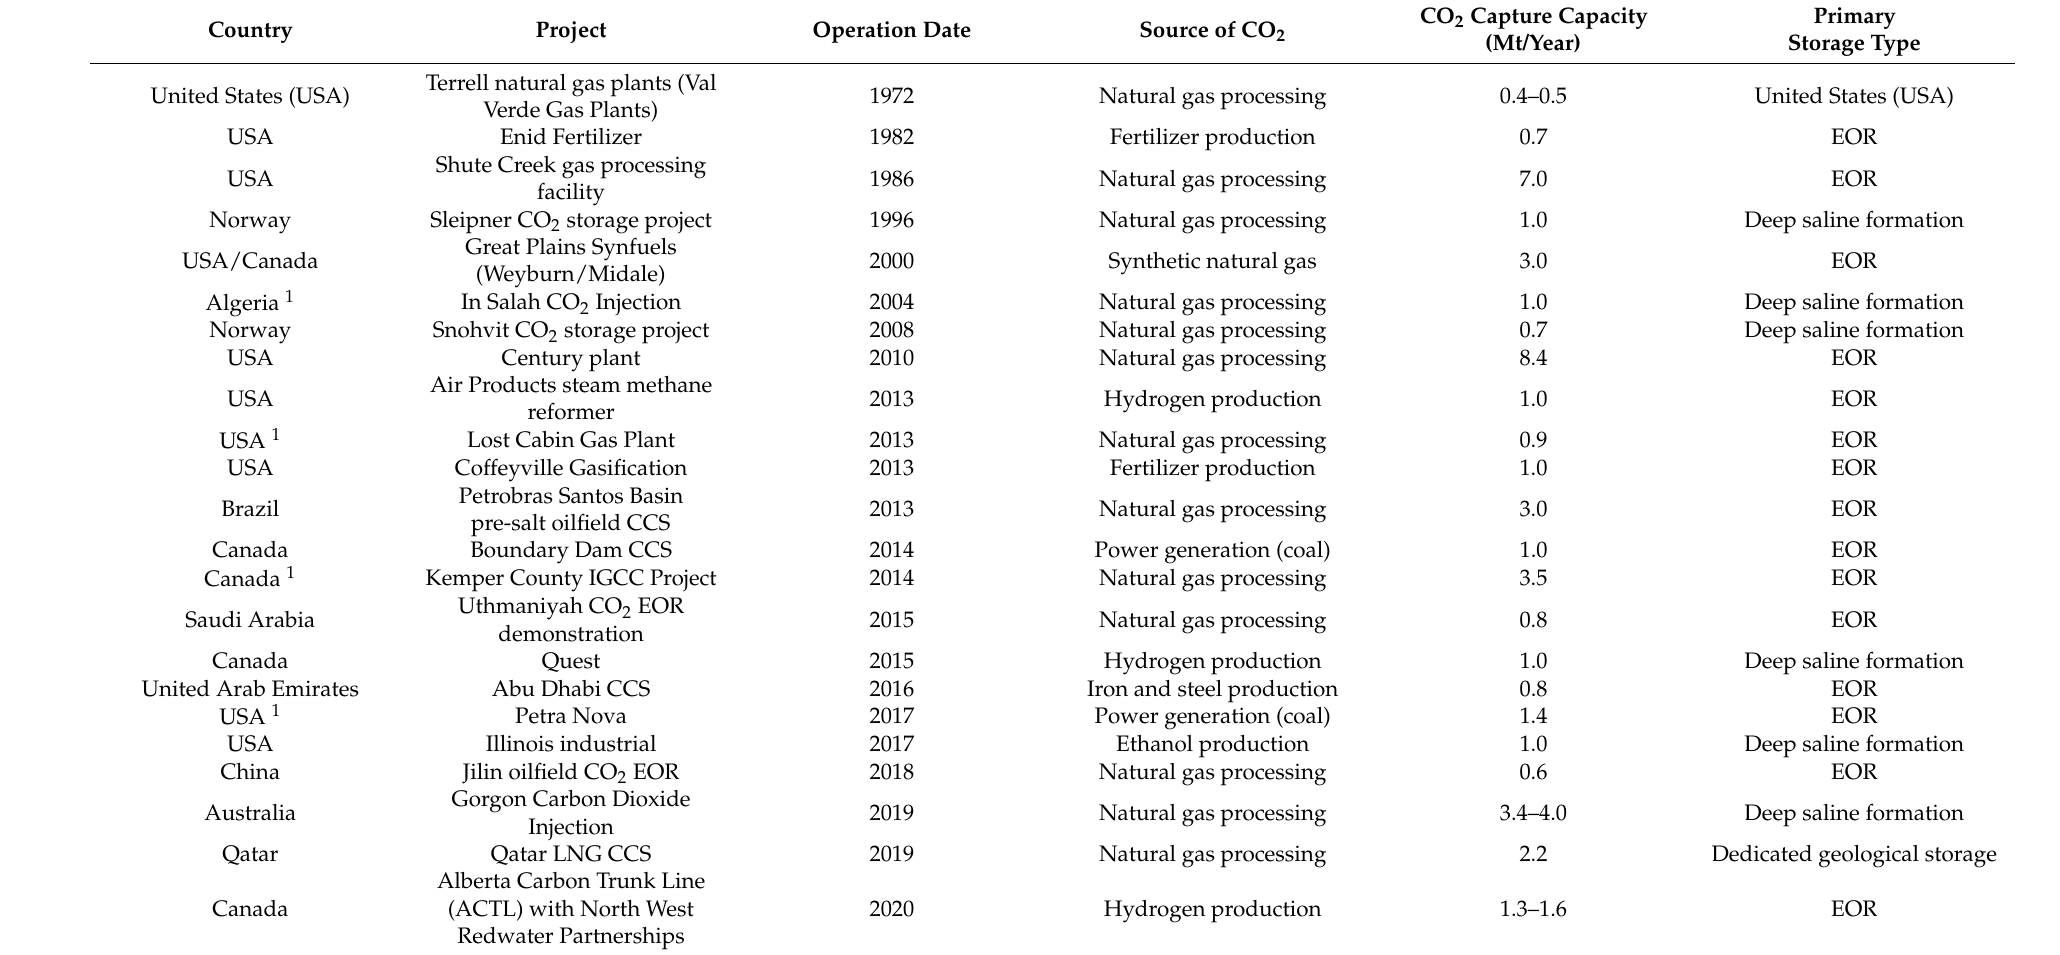
Table 2. Commercial large-scale CCUS facilities in operation between 1972 and 2021 ( 1 facility out of operation in 2021)